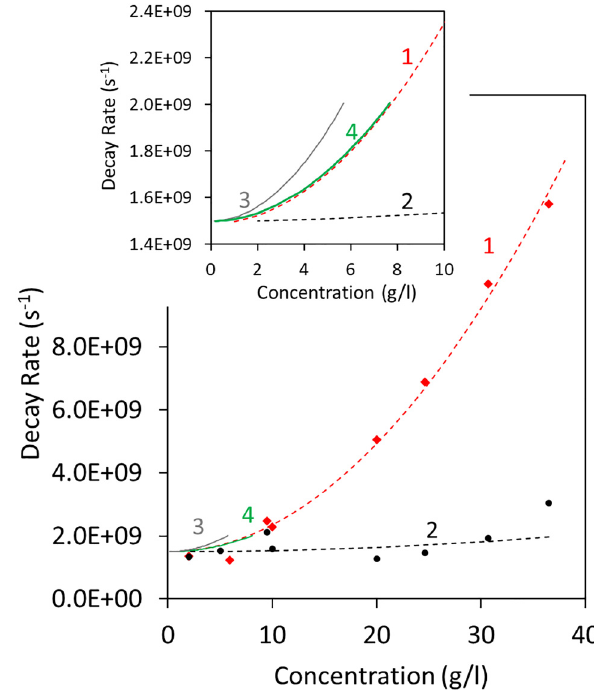
Figure 6: Concentration dependence of the emission decay rate in HITC:PMMA on glass (trace 1: Red diamonds and red dashed line) and in anodic alumina membranes (trace 2: Black circles and black dashed line). The dashed lines are the best fits of the experimental pointswithformula( A + W ) + γν 2 .Traces3and4:Sameastrace2but, plotted against the scaled concentrations f ν rather than the original concentration ν . Trace 3: f = 0.15, poor match with trace 1. Trace 4: f =0.20,goodagreementwithtrace1.Inset:Zoomedpartofthemain